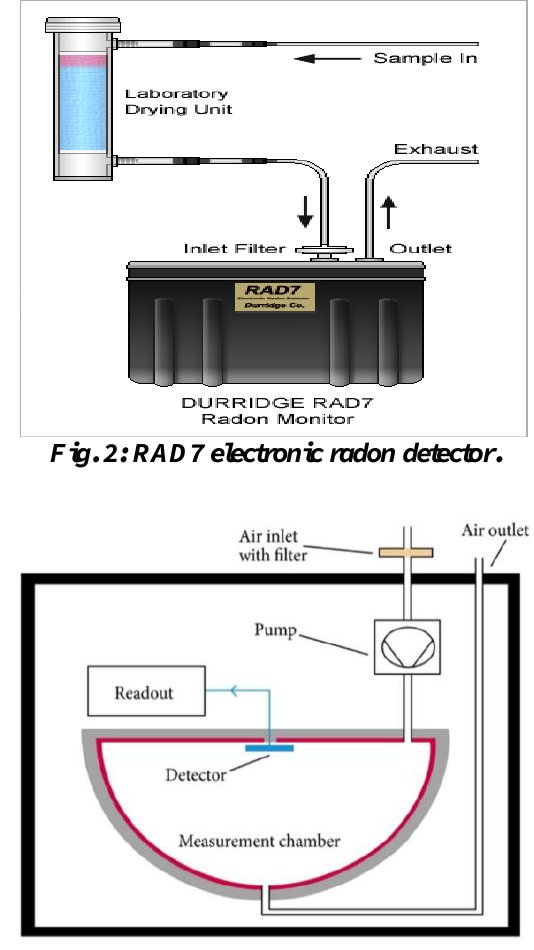
Fig. 3: Measurement-chamber-of- the-RAD-7-detect.